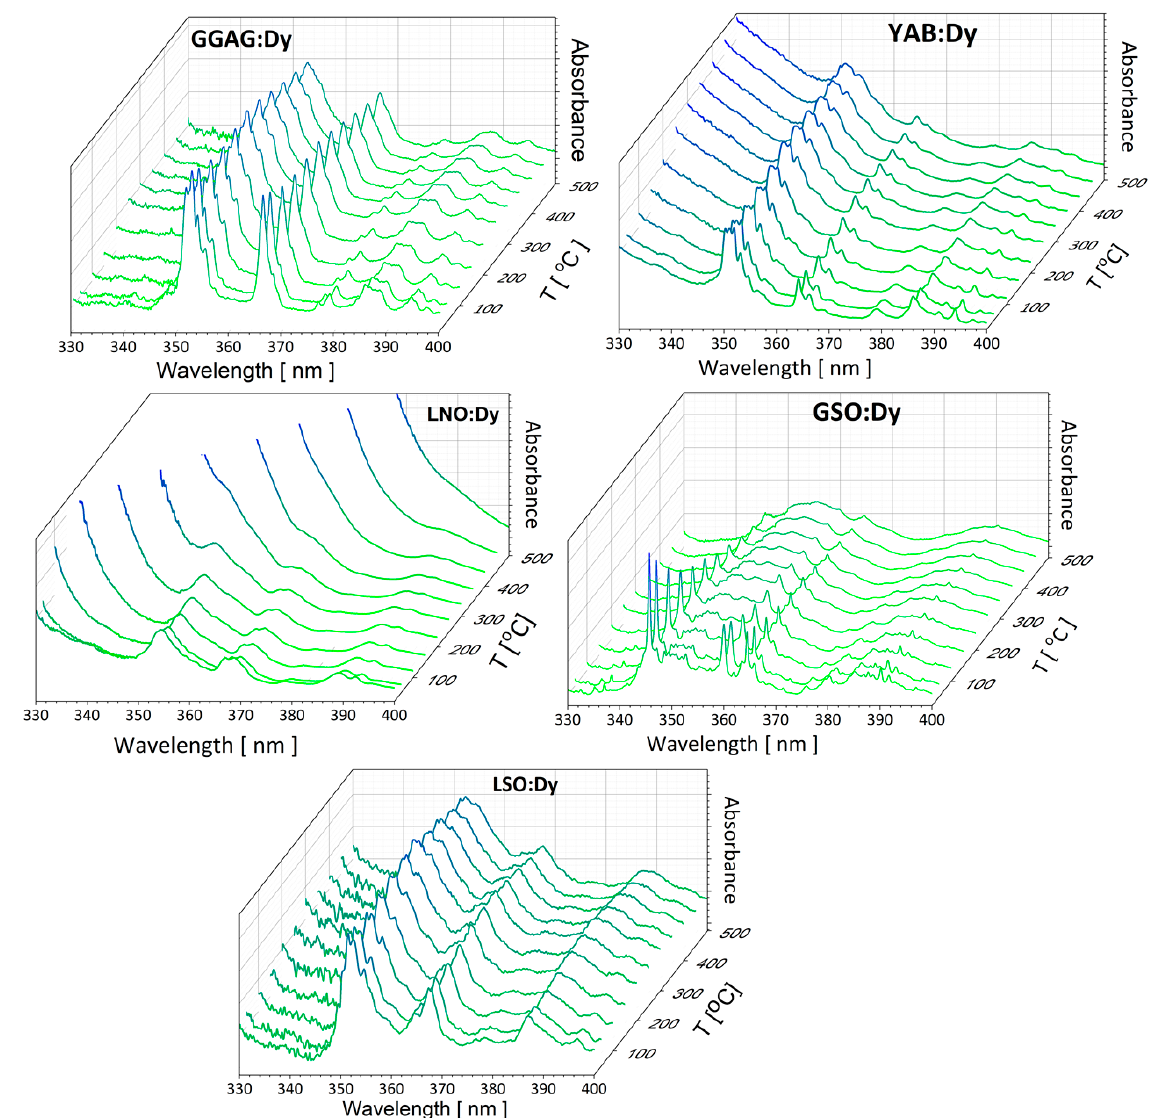
Figure 4. Optical absorption spectra in the UV-blue region recorded at several different temperatures between 295 K and 775 K for the systems under study. For the sake of clarity, the spectral region was restricted to 330–400 nm.